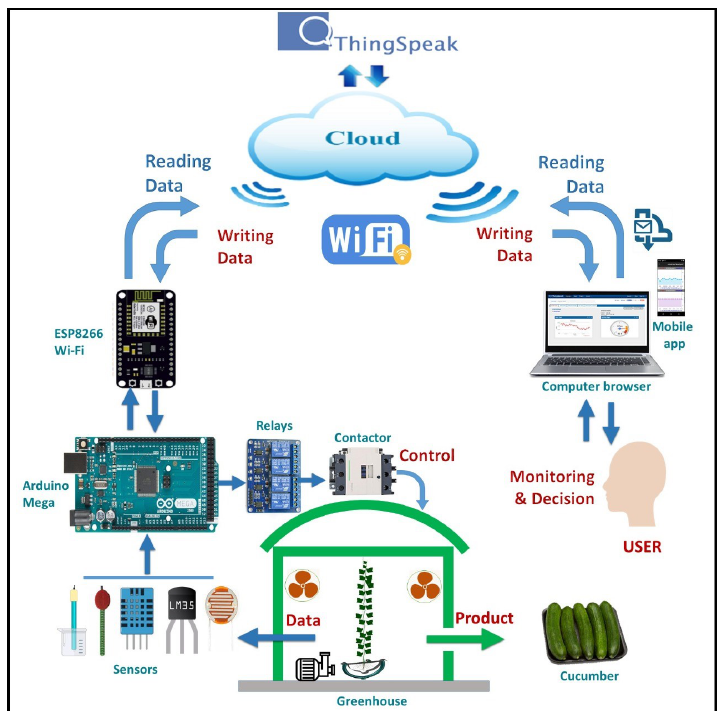
Figure 3. Overall system architecture of cloud-based IoT